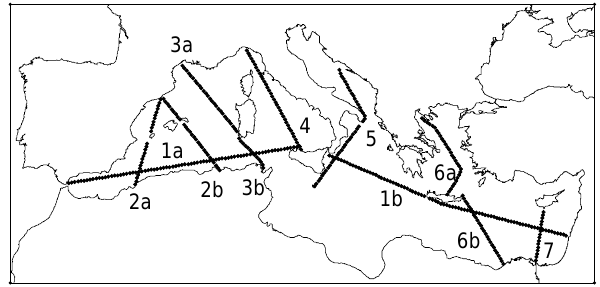
Fig. 1. Design of the VOS track